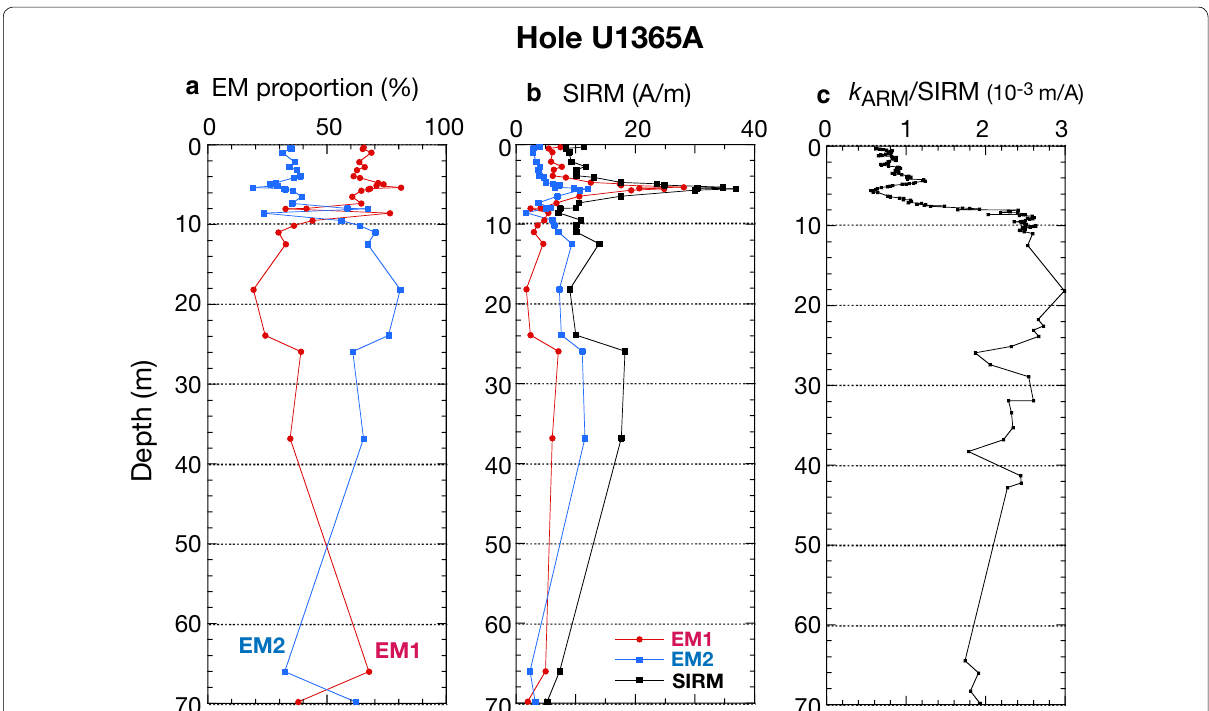
Fig. 9 Downcore variations of FORC-PCA EMs and k ARM /SIRM for Hole U1365A. a Proportions of EM1 (red) and EM2 (blue). b SIRM (black) and the contribution of individual EMs calculated from the respective proportions. c Variations of k ARM /SIRM (Shimono and Yamazaki 2016). Note the synchronous EM and k ARM /SIRM changes at ~ 8 m in depth